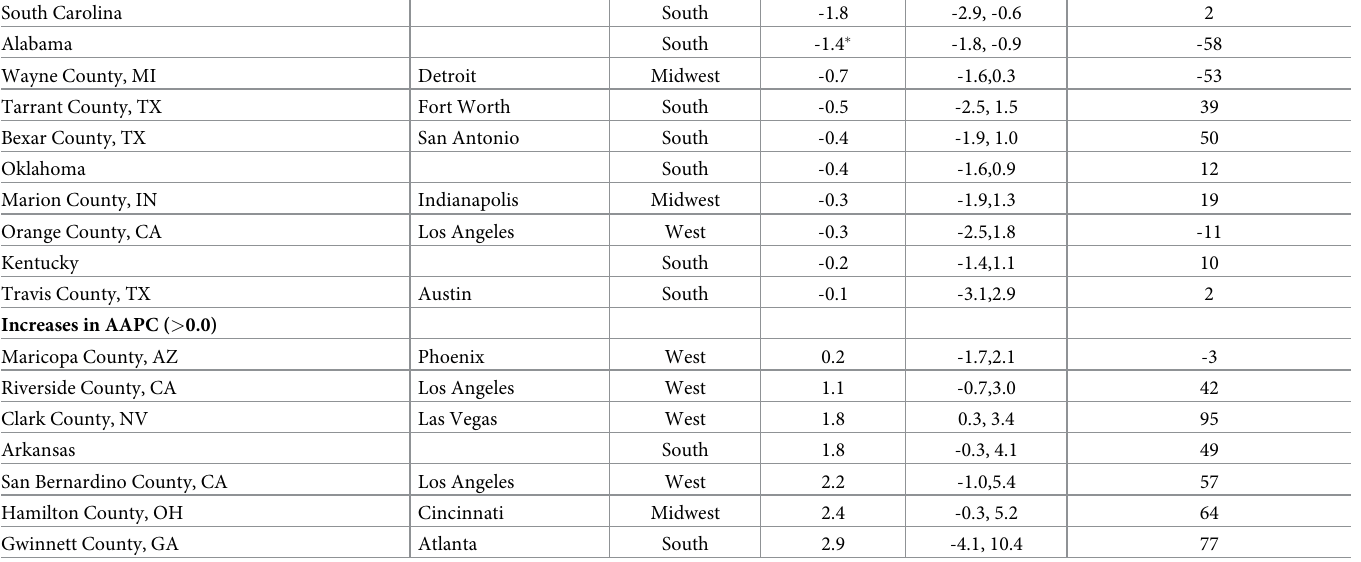
Hotspots with moderate declines in HIV diagnosis rates with an AAPC of -5.0 to -2.5 are shown in Table 1 and Fig 1c; hotspots with the smallest declines in HIV diagnosis rates with an AAPC of -2.5 to 0.0 are shown in Table 1 and Fig 1d; and hotspots with increases in HIV diag- nosis rates with an AAPC of > 0.0 are shown in Table 1 and Fig 1e. The change in the number of new HIV diagnoses in the hotspots from 2008 to 2017 is shown in the rightmost column in Table 1. Overall, 43 hotspots had a net decrease and 14 had a net increase in the number of HIV diagnoses. The 10 hotspots with greatest absolute declines in the number of HIV diagnoses were the District of Columbia and Los Angeles, New York, Baltimore City, Philadelphia, Cook, Kings, Miami-Dade, Bronx and Broward Counties. Six of these hotspots were in the group with the largest declines in AAPC, and four were in the group with moderate declines in AAPC. The largest declines in the number of new HIV diagnoses clustered geographically in Washington, DC, Baltimore, Philadelphia and New York City; Miami and Fort Lauderdale; and Atlanta, Chicago, Los Angeles and San Francisco. Nine hotspots had significant joinpoints (Table 2), indicating evidence of two distinct rate trends over the ten-year period. Of these, there were three with a significantly declining rate followed by a significantly declining but lower rate (Baltimore City, Bronx and Queens Coun- ties), two with a significantly declining rate followed by a significantly declining but higher rate (New York and San Francisco Counties), and four with a significantly declining rate fol- lowed by a flat or non-significantly increasing rate (Alabama and Broward, Orange and Tar- rant Counties). Unadjusted and multivariable adjusted associations of hotspot characteristics with AAPC are shown in Table 3. HIV diagnosis rate in 2008 was strongly associated with decreasing AAPC (r = -0.81, p < .001; partial correlation = -0.72, p < .001). That is, the higher the HIV diagnosis rate in 2008, the greater the decline in rate over the next 10 years. The Northeast showed a steeper decline in the HIV diagnosis rate than other regions in both the